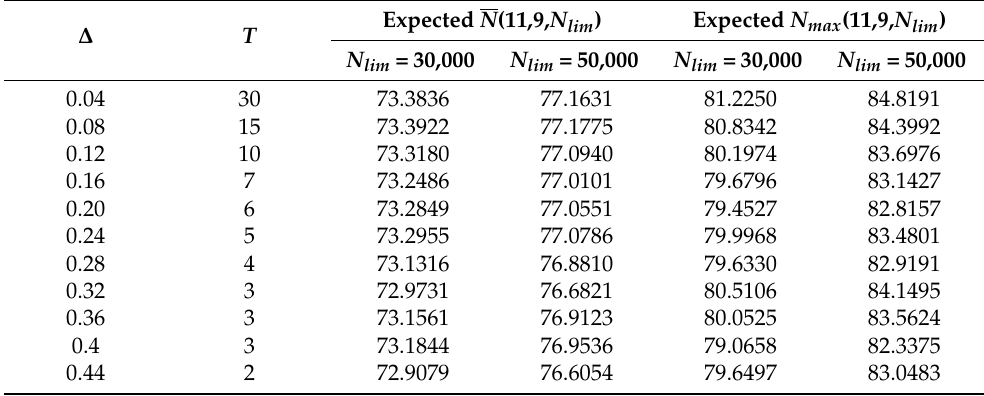
depending on the step ∆